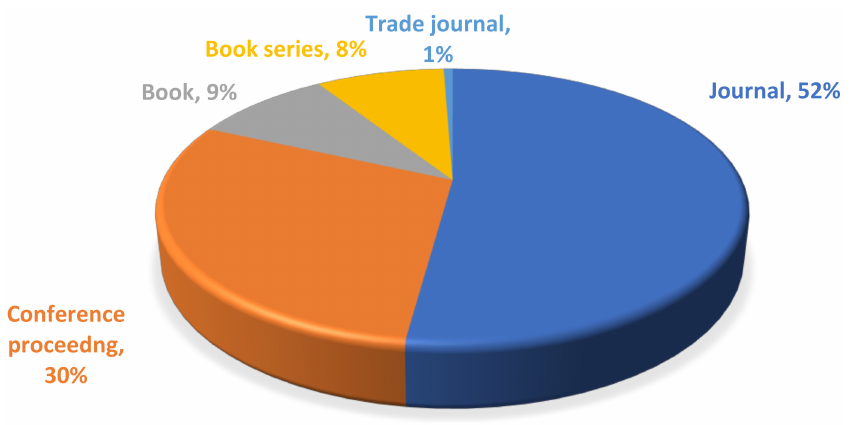
Figure 5. The types of sources.